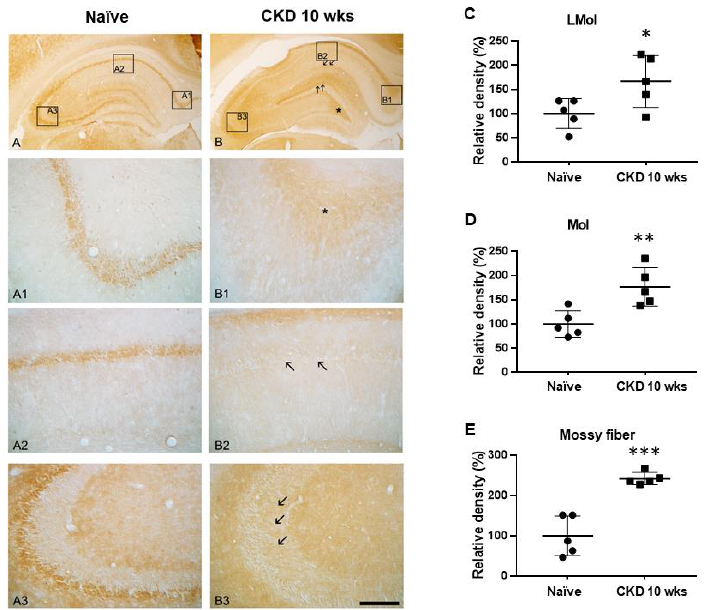
Figure 5. Upregulation of NHE1 immunoreactivity in the hippocampus of CKD model rats. NHE1 immunoreactivity in the hippocampus of naïve rats was mainly observed in the neurons ( A ): subiculum ( A1 ), CA1 ( A2 ), and CA2-3 ( A3 ). CKD did not affect NHE1 expression in the neurons of the hippocampus (( B ) and arrows of ( B2 )). NHE1 expression was enhanced in the neuropil at stratum lacunosum-moleculare, molecular layer (arrows), and hilus (*) regions in the CKD rats ( B ). CKD rats showed increased NHE1 immunoreactivity in the subiculum and alveus regions (( B1 ), *) and mossy fiber (( B3 ), arrows) of the hippocampus compared with naïve rats. NHE1 expression in the CA1 region was decreased in the neurons of CKD rats (( B2 ), arrows). The NHE1 densitometric results were similar to the immunohistochemical data (( C ), LMol; ( D ), Mol; ( E ), CA2- 3). Scale bar = 400 μm (panels ( A , B ) ), 50μm (panels ( A1 – A3 ) and ( B1 – B3 )). * p < 0.05, ** p < 0.01, *** p < 0.001 by one-way analysis of variance, n = 5/group.